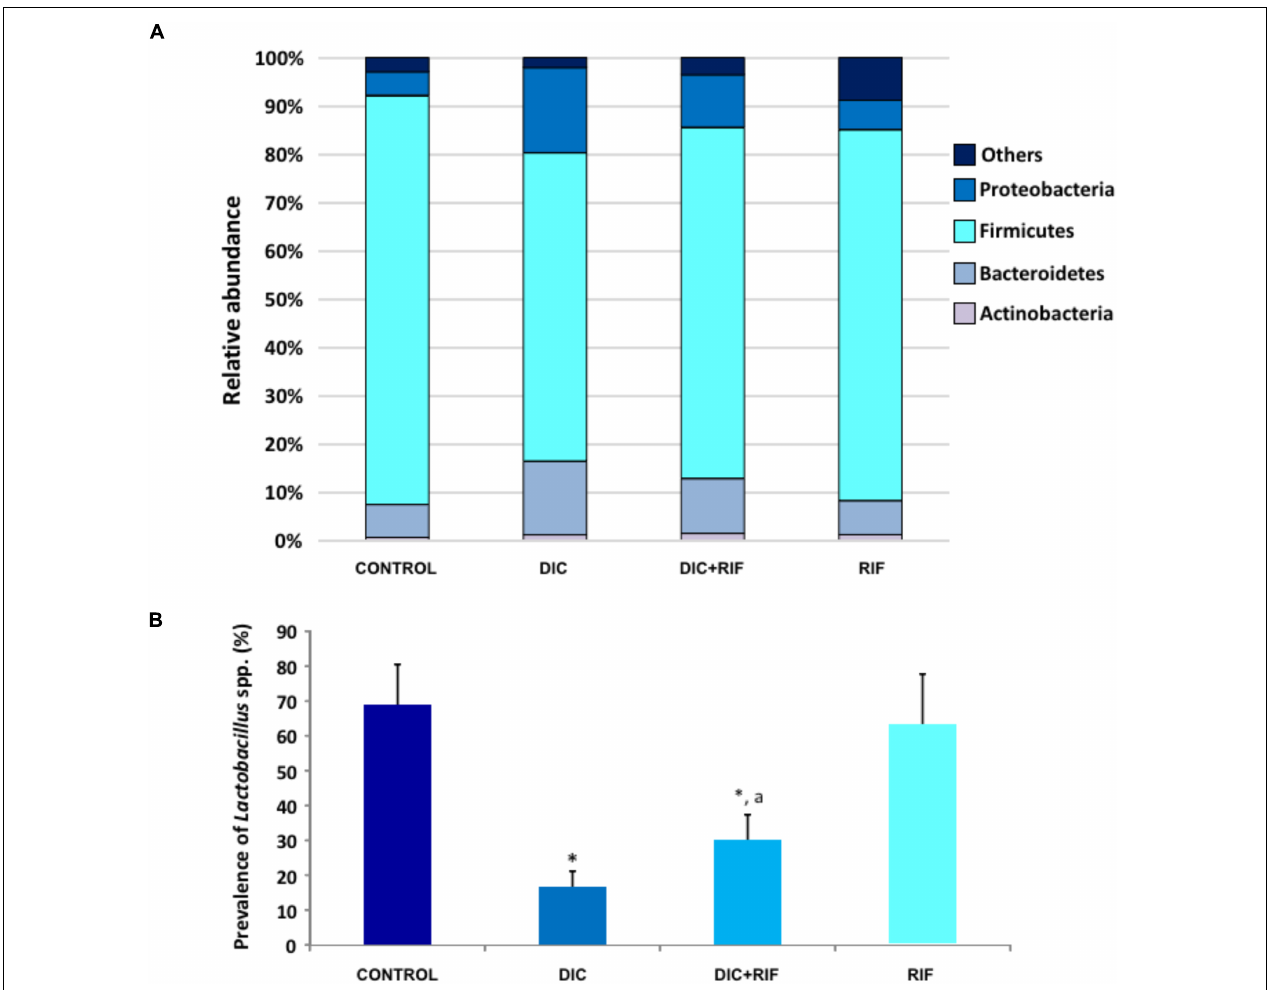
FIGURE 6 | (A) Relative abundance of Proteobacteria , Firmicutes, Bacteroidetes, and Actinobacteria and (B) prevalence of Lactobacillus spp. in the ileum of rats treated with vehicle (Control), diclofenac (DIC, 4 mg/kg BID), diclofenac plus rifaximin (DIC+RIF, 50 mg/kg BID), or rifaximin (RIF) for 14 days. Each column represents the mean ± SEM obtained from 10 animals. ∗ p < 0.05, significant difference versus Control; a p < 0.05, significant difference versus diclofenac